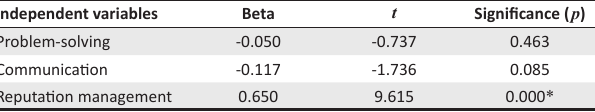
TABLE 6: Influence of independent variables on behavioural intention to use social